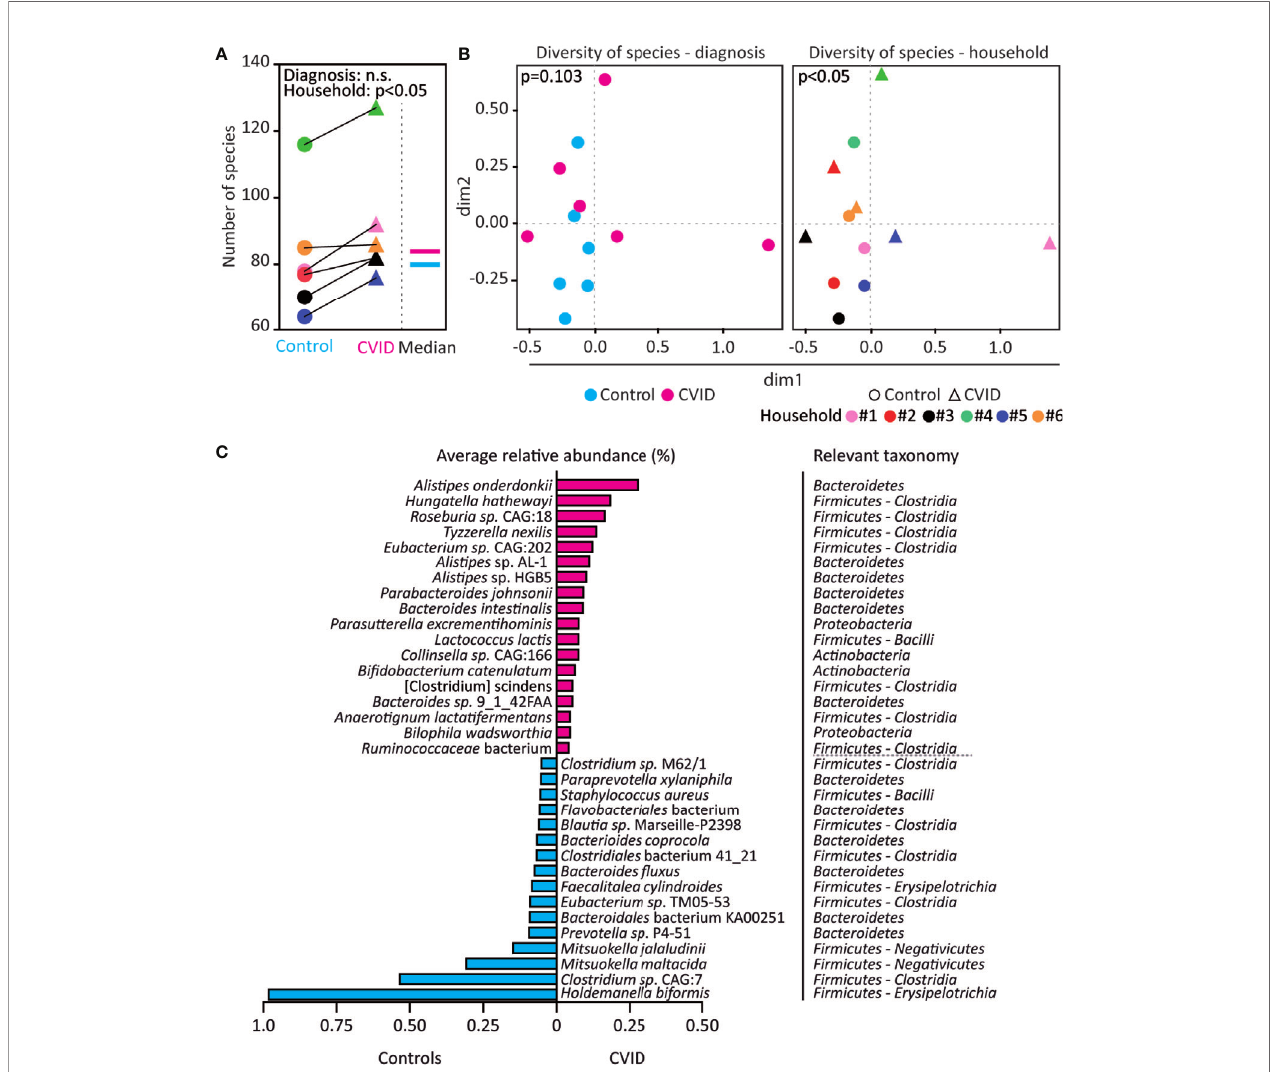
FIGURE 2 | The CVID fecal microbiome shows increased bacterial diversity and differences in bacterial species. (A, B) CVID patients have more bacterial species than healthy housemates, irrespective of the total number of bacterial species identi fi ed in the corresponding CVID-control pairs. However, the microbiome composition also associates with household in addition to diagnosis. (C) Bacterial species with signi fi cantly increased (magenta) and decreased (cyan) relative abundance in CVID patients compared to healthy housemates (q<0.001, p-values adjusted for control of false discovery rate). Unpaired Mann-Whitney (for Diagnosis) and paired Wilcoxon tests (for Household) (A) , Chao dissimilarity matrix, NMDS plot, and nonparametric test ANOSIM (B) , and DESeq2 method (C) were used to calculate statistical differences. The complete analysis of taxonomic diversity, including a list of relative abundancies, is shown in Figure S1 , Table S3 ,